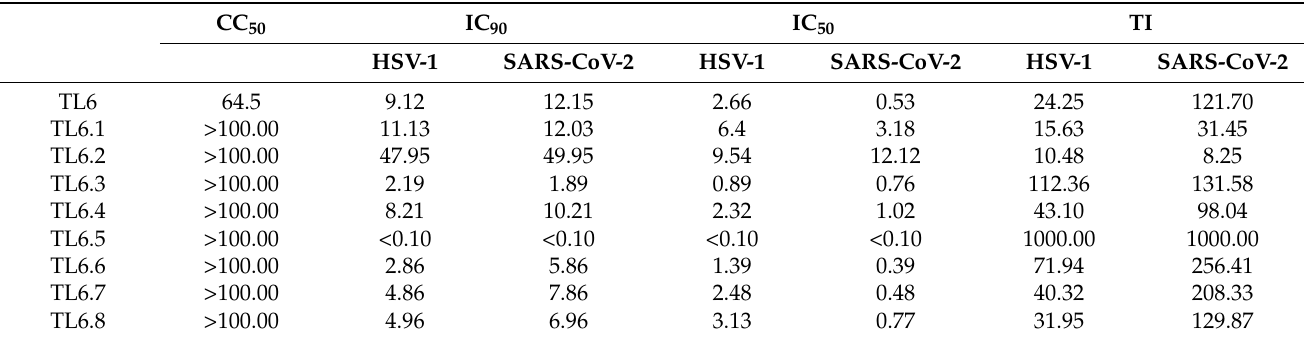
Table 6. CC 50 , IC 90 , IC 50 and TI calculated for HSV-1 and SARS-CoV-2. Concentrations are expressed in µ M.